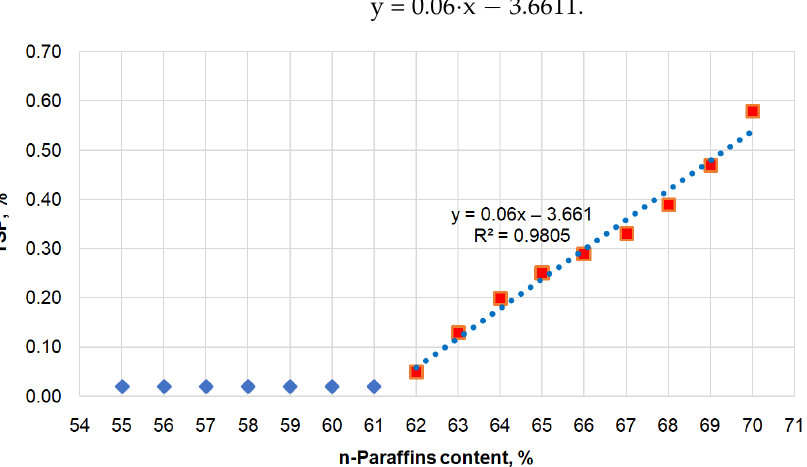
Figure 5. Influence of n-paraffins on the manifestation of incompatibility with an asphaltene content of 0.5 wt.